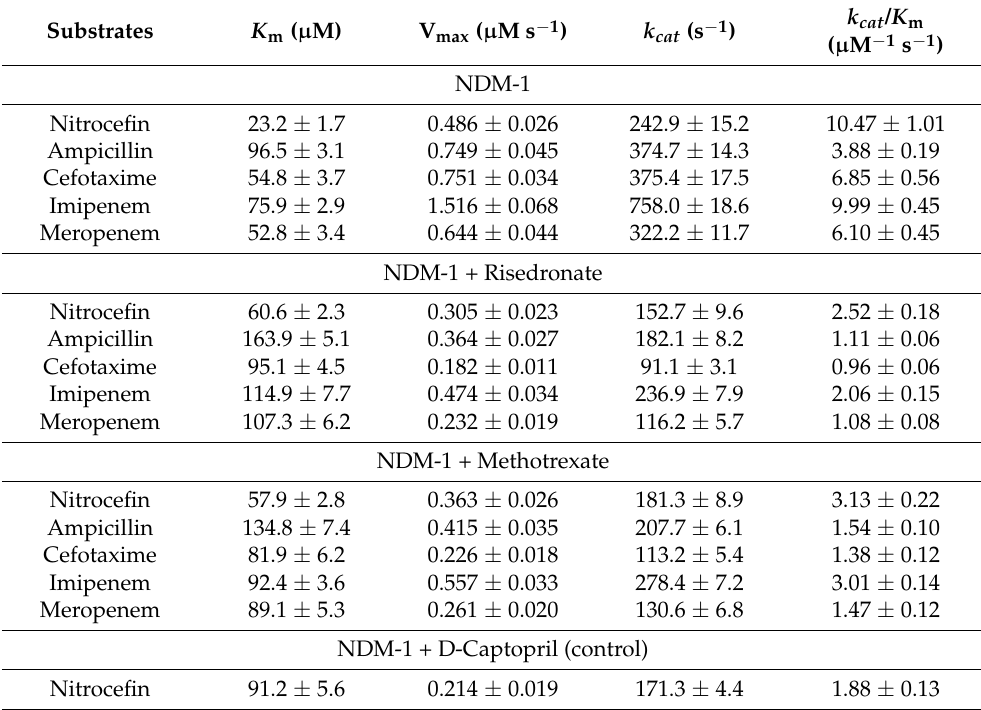
Table 4. Steady-state enzyme kinetics of NDM-1 in the presence of risedronate and methotrexate.